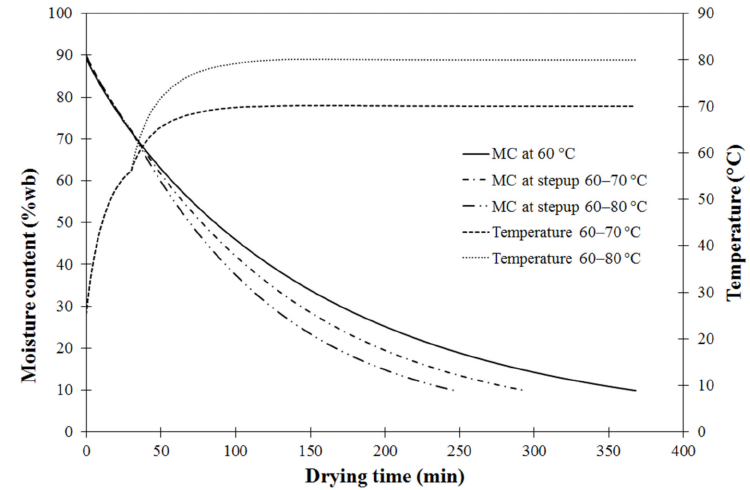
Figure 3. Comparison of simulated moisture content of carrot cubes at fixed 60 ◦ C and two modes of step-up